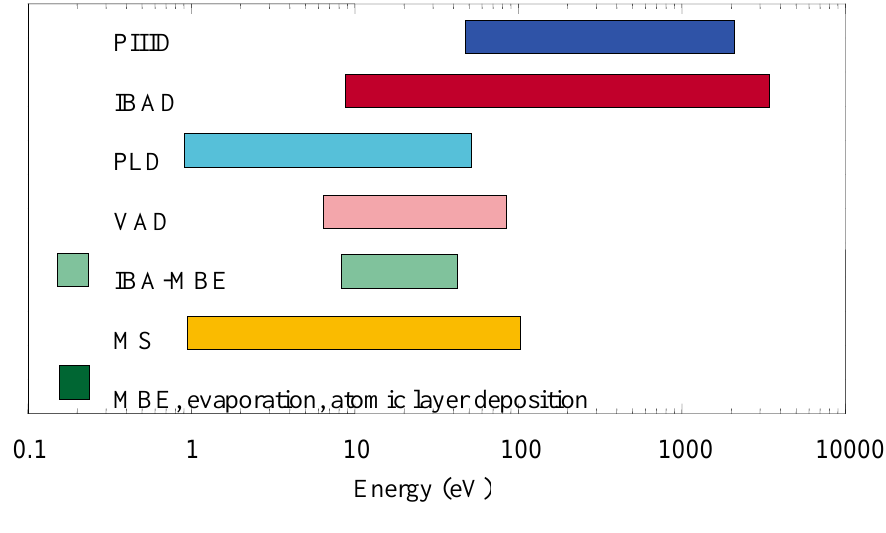
Figure 1 . Typical energy ranges for different PVD processes. PIIID = plasma immersion ion implantation and deposition; IBAD = ion beam assisted deposition; PLD = pulsed laser deposition; VAD = vacuum arc deposition; IBA-MBE = ion beam assisted molecular beam epitaxy; MS = magnetron sputtering; MBE = molecular beam epitaxy.